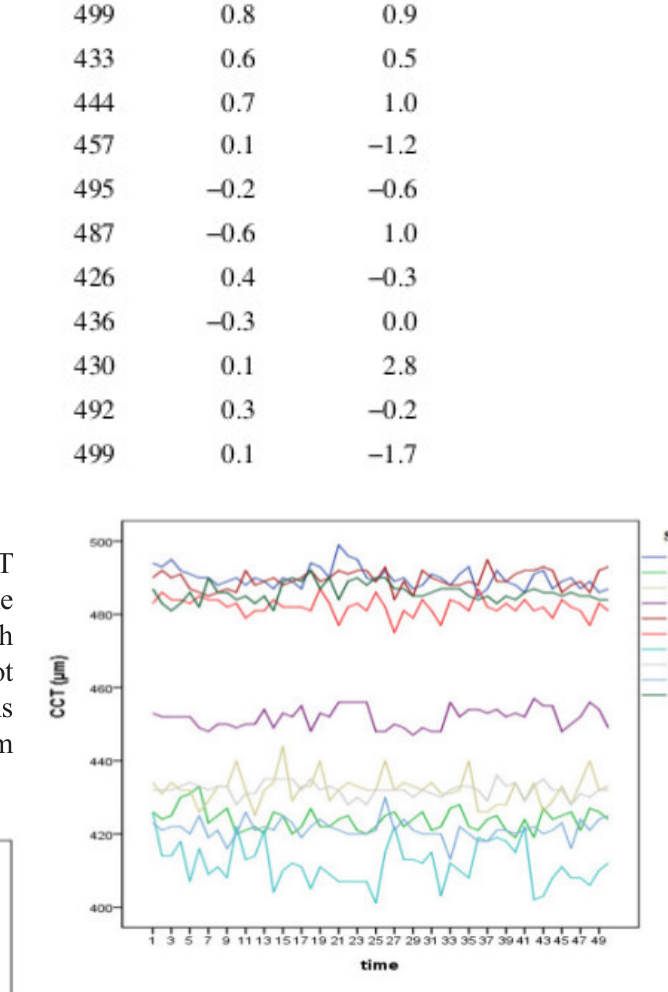
Figure 2: Profiles of short-term variation of the 50 measurements of the CCT for 10 subjects are indicated. The CCT profile of subject 7 (bottom light blue colour) appears to be more variable (401 to 426 µm) than the